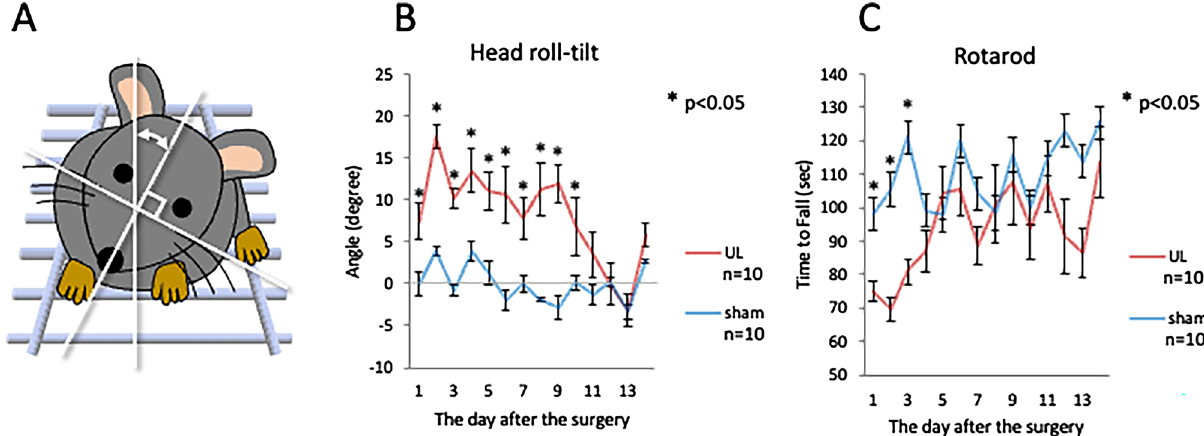
Figure 1. Behavioral observation. ( A ) Measurement of head roll-tilt. The angle of the sagittal plane from the vertical plane was used to evaluate vestibular imbalance. ( B ) Changes in the head roll-tilt after surgery. ( C ) Post- surgery performance in the rotarod